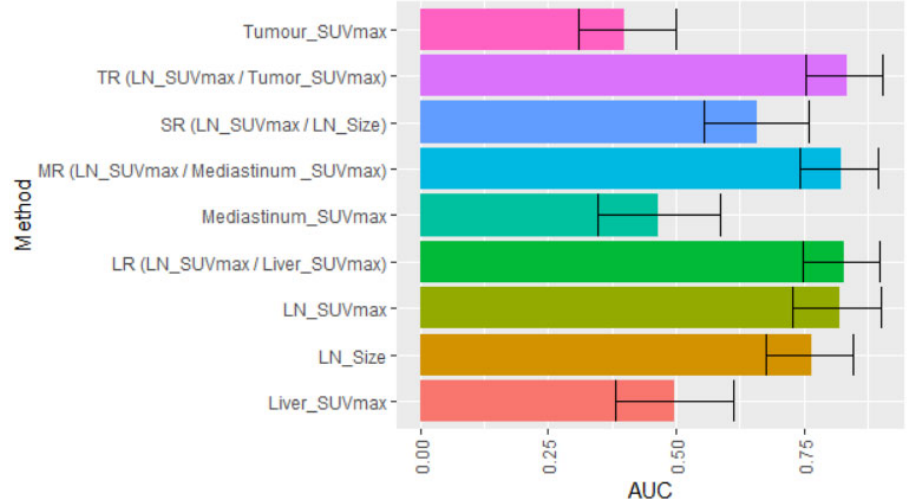
Figure 2. Summary of data from ROC curve analysis of individual markers for mediastinal (N2) nodal involvement and normalisation of lymph node SUVmax values (LN_SUVmax) to factors of interest. Data presented for individual bar graphs represent data on each AUC, with 95% confidence interval highlighted (ROC = receiver operating characteristic; AUC = area under curve).